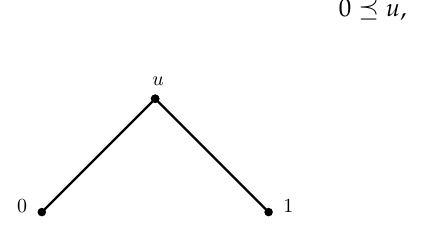
Figure 1. Ambiguity partial order